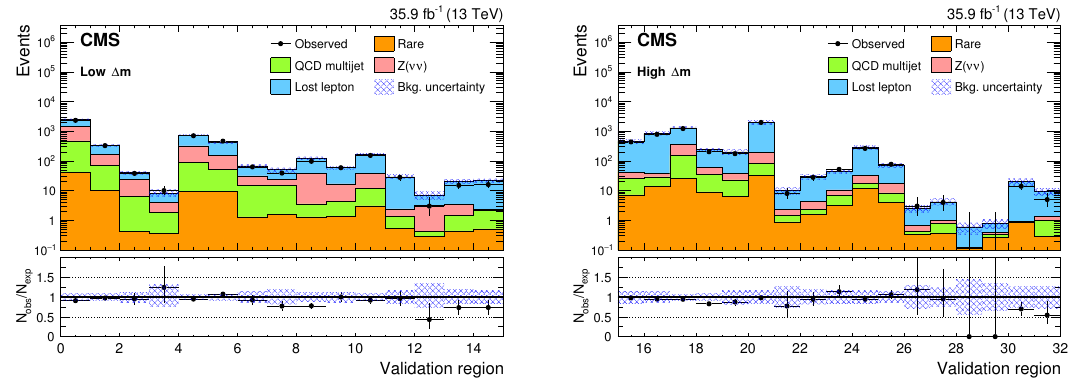
Figure 4 . Observed data and SM background predictions in the low- p miss the low (cid:1) m (left) and high (cid:1) m (right) selections. Ratios of the observed to SM predicted event counts derived from control regions are shown in the lower panel of each plot. The shaded blue band represents the statistical uncertainty combined with the systematic uncertainty resulting from the top quark and W boson tagging correction factors on the background